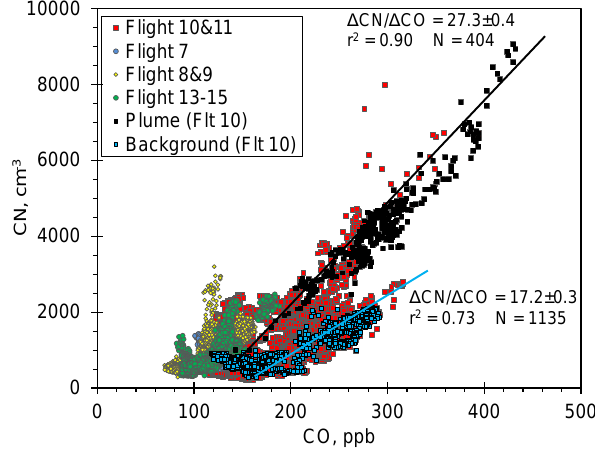
Fig. 7. Plot of aerosol particle number concentration (CN) vs. CO mixing ratio (2-s data) from